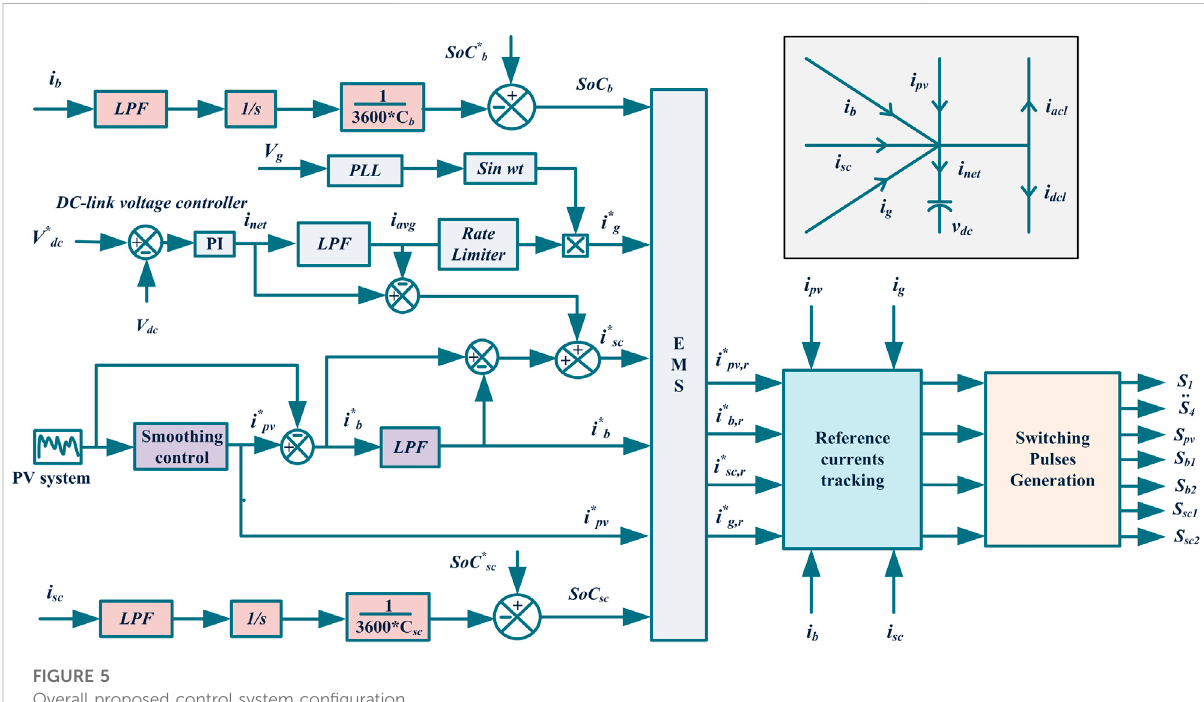
FIGURE 5 Overall proposed control system con fi